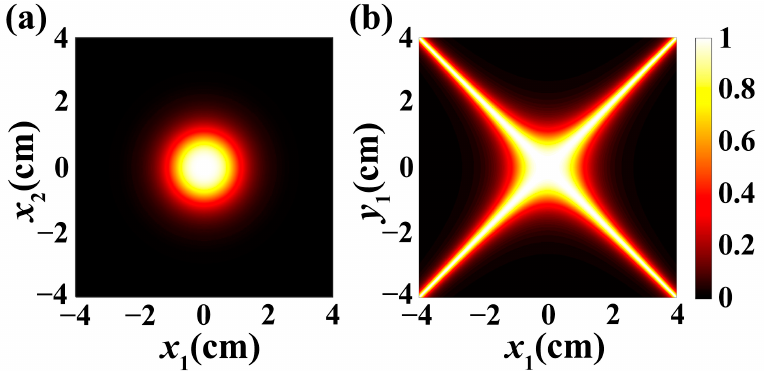
where δ denotes the spatial coherence length. Equation (6) shows that the spectral DOC is not only related to the separation, but also to the specific positions of two points, that is, not a homogeneous function, it is non-uniformly correlated and it takes the form of a Lorentz function. Therefore, this new type of partially coherent source, whose CSD is given by Equations (5) and (6), is referred to as a LNUC source. The density plot of the absolute value of the spectral DOC of a LNUC source is shown in Figure 1. The beam parameters are set to w 0 = 1 cm and δ = 1 cm. It is found that the distribution of the spectral DOC displays circlar symmetry in the x 1 − y 1 plane and rectangular symmetry in the x 1 − x 2 plane. In the x 1 − x 2 plane, the high-coherence region of the LNUC beam is confined to the center and two diagonal lines of the beam in the source plane, which confirms that the correlation structure of such a source is of non-uniform type. We therefore obtain a new type of non-uniformly correlated source with a prescribed correlation function.